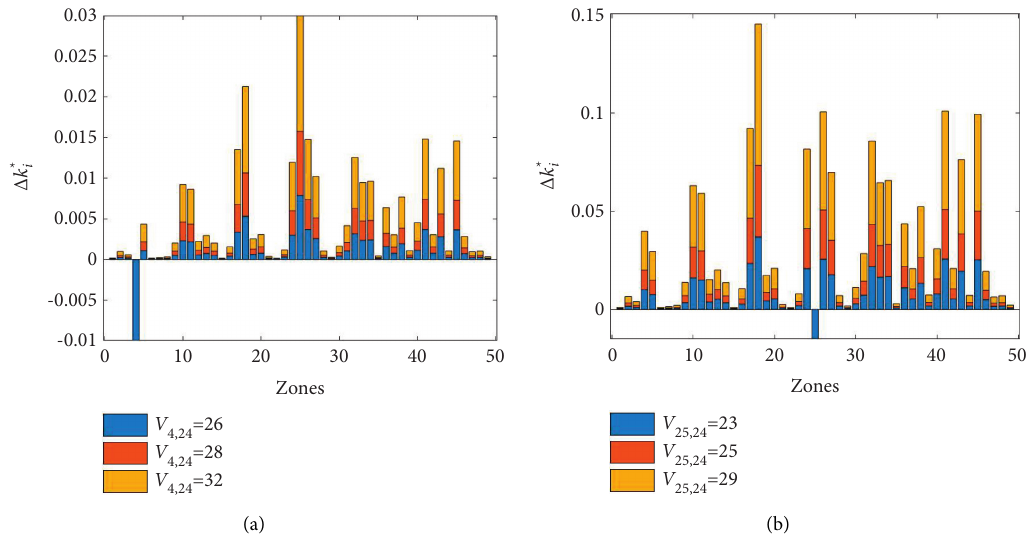
Figure 8: The change of k ∗ i ∈ V , as V and V increase. (a) The change of k ∗ i , ∀ i ∈ V , as V i , ∀ 4 , 24 25 , 24 increases. ∀ i ∈ V , as V 25 , 24